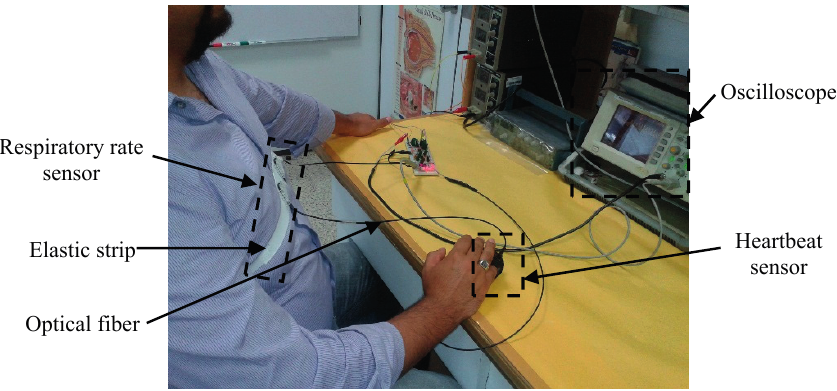
Figure 8. Test subject using fiber optic sensor.